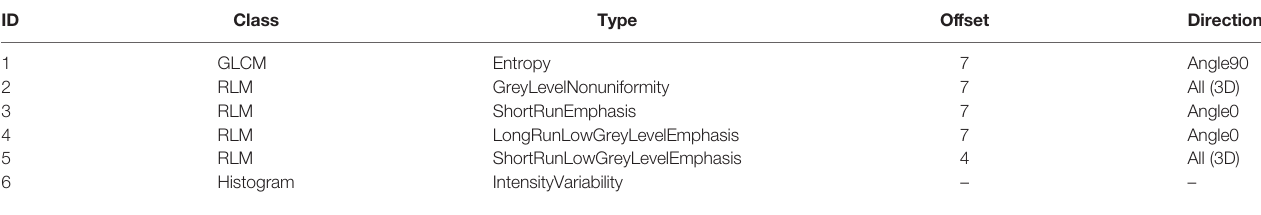
TABLE 2 | Speci fi c parameters and feature extraction in six